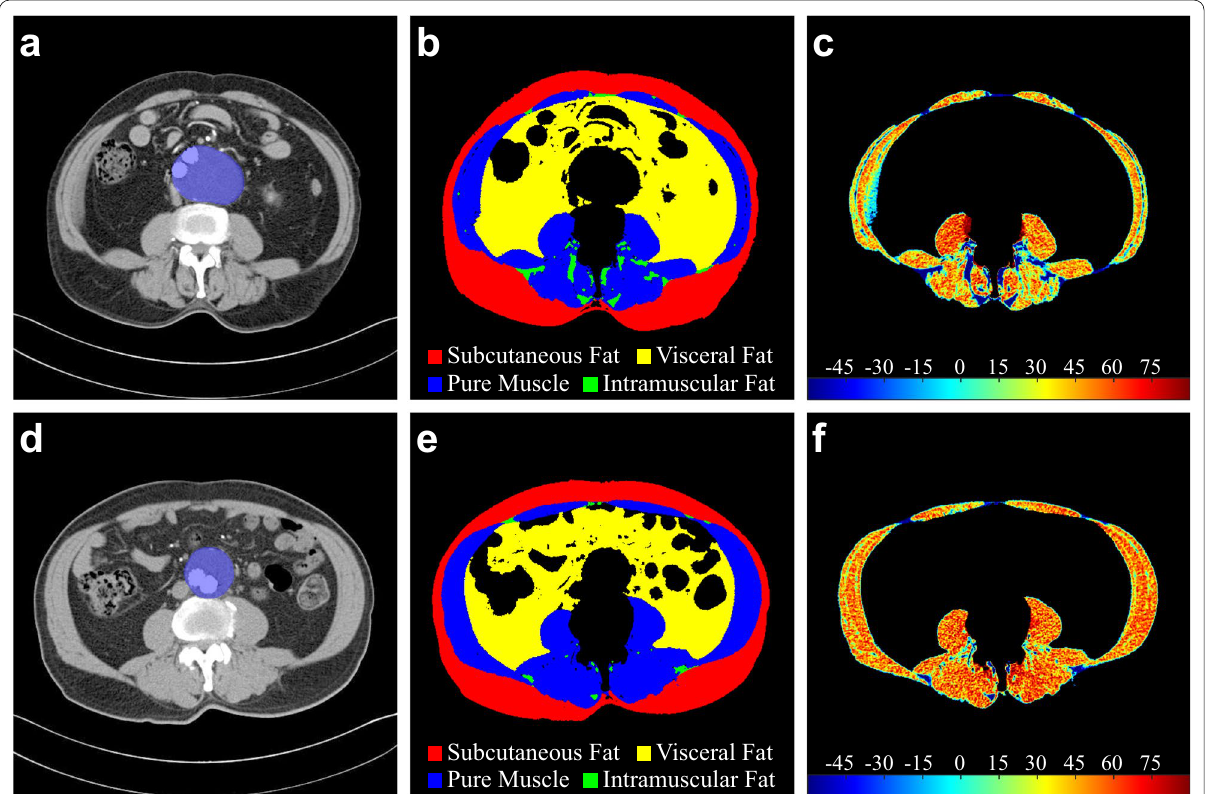
Fig. 4 Examples of abdominal aortic aneurysm growth. a–c A patient with aneurysm expansion. d–f A patient with a shrunken aneurysm. a Maximal axial plane of the aneurysm (the blue area). b Body composition segmentation results of image a. c Pseudocolor image of the total muscle region (intramuscular fat and pure muscle). The red area reflects the high CT value, and the blue reflects the low value (Hounsfield Unit). d – f represent the same meaning as a – c